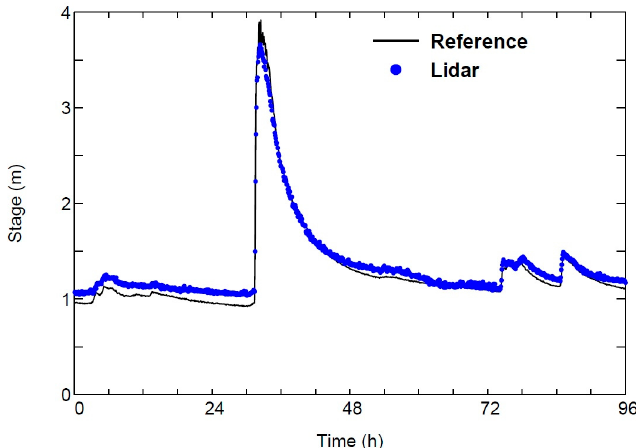
Figure 5. Details of the monitoring campaign showing a flash flood (20 September 2015). Table 1. Performances of the inclined Lidar technique during the experiment in the Amacuzac River. Numbers of attempts (every 5